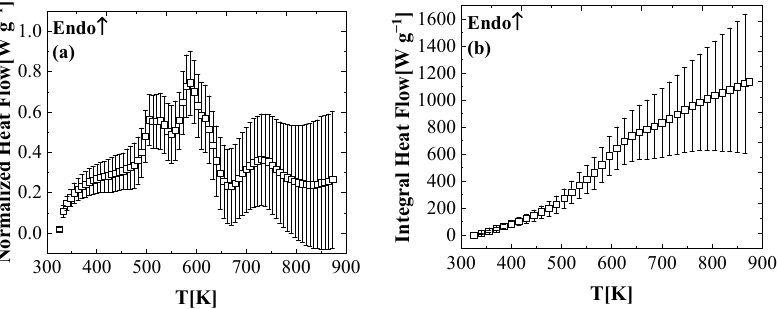
Figure 4. Experimental DSC data collected in nitrogen at a heating rate of 10 K min − 1 presented as ( a ) normalized heat flow and ( b ) integral heat flow.